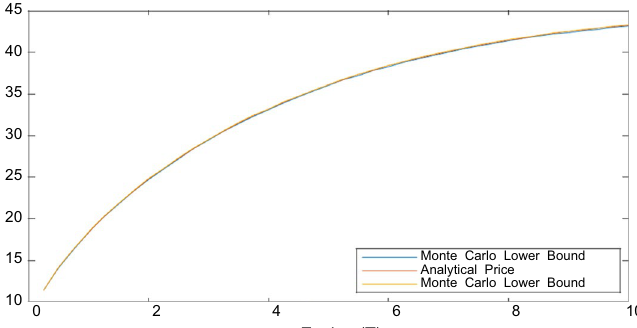
Fig. 5 Monte Carlo bounds versus semi-analytical prices